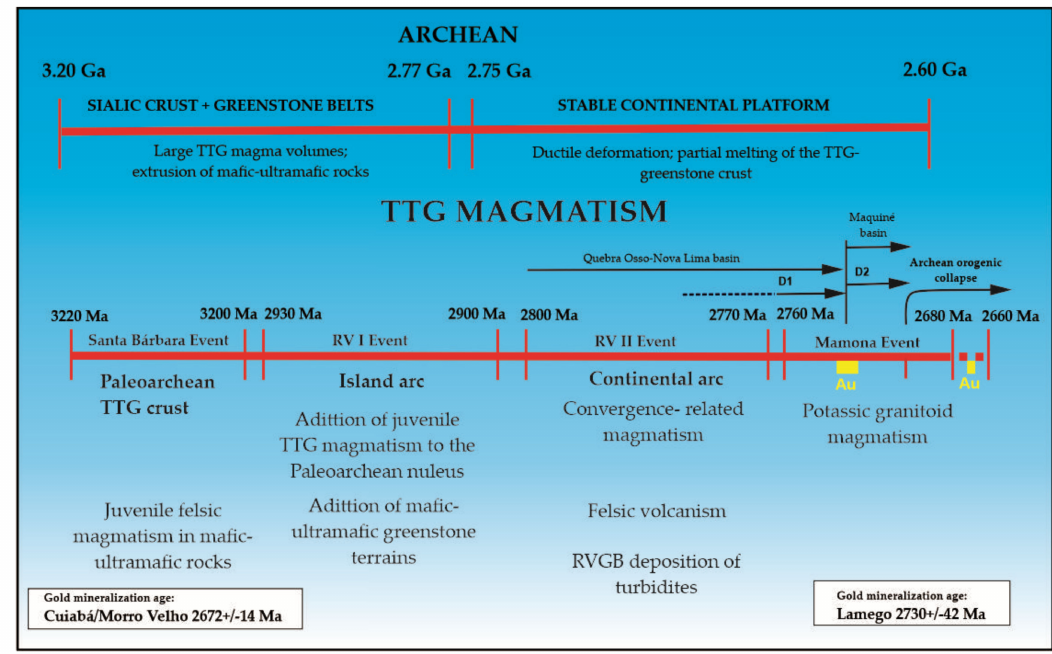
Figure 17. Integration of Archean magmatic events (derived after [41]) and D1–D2 deformations (this work) in the context of gold mineralization ages based on Cuiab á -Morro Velho [8] and Lamego